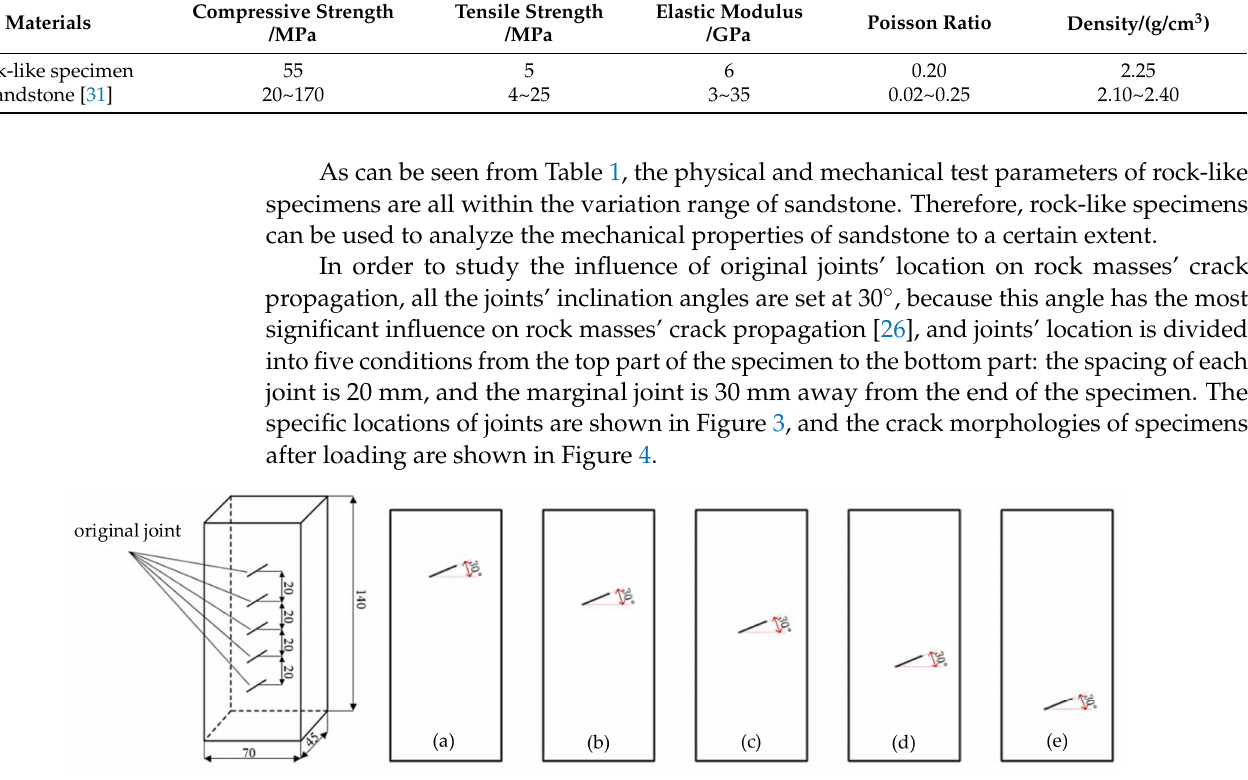
Figure 3. Original joint location and the space between joints with ( a ) top joint, ( b ) upper joint, ( c ) middle joint, ( d ) lower joint and ( e ) bottom joint.